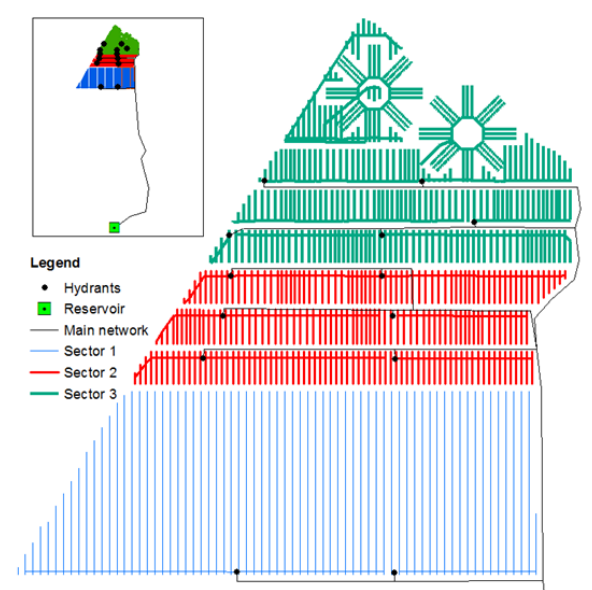
Figure 5. Experimental farm of Cordoba University.